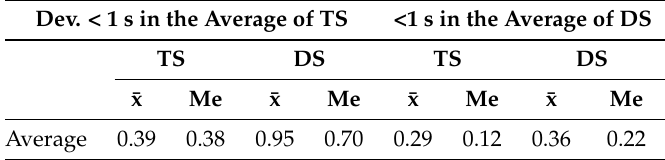
Table 6. Results of the ABD testing for recordings with the average ABD < 1 s. Dev. < 1 s in the Average of TS <1 s in the Average of DS